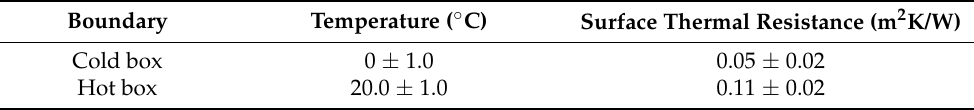
Table 4. Boundary conditions for mock-up